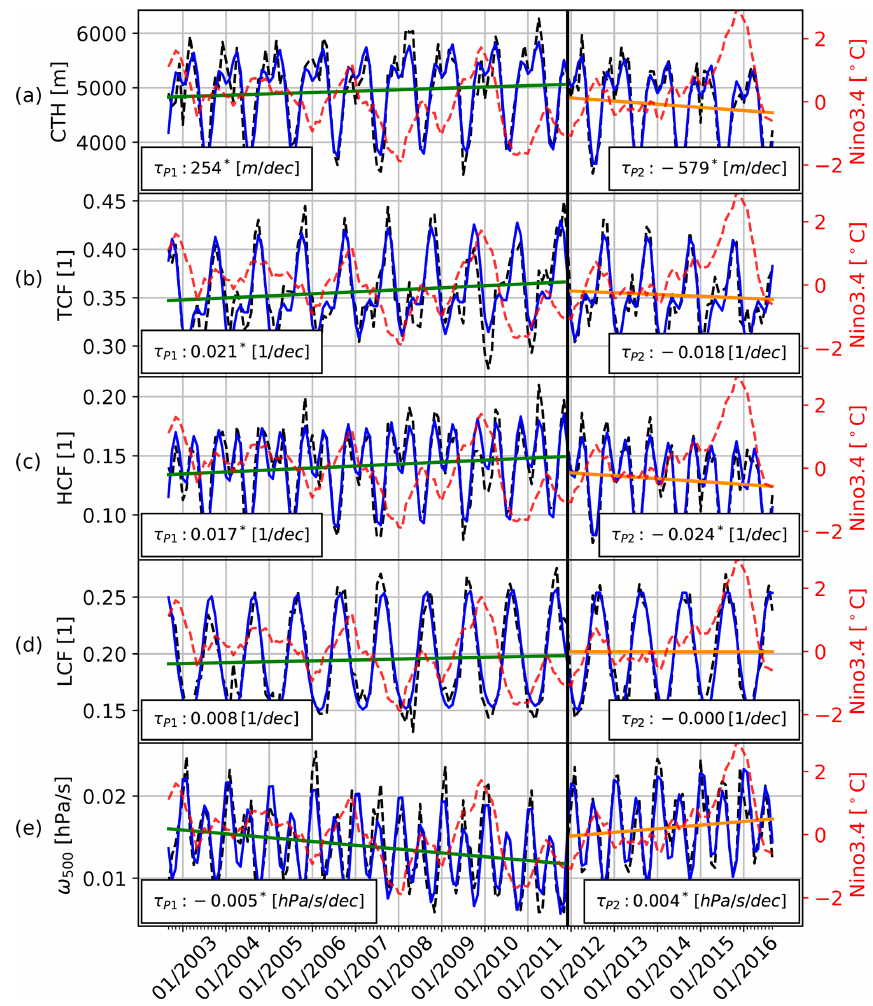
Figure 4. Quantification of temporal linear changes in the tropical Atlantic mean associated with ENSO phase transition. (a) CTH, (b) TCF, (c) HCF, (d) LCF, and (e) ω 500 . The MODIS data are displayed in black, and in blue the applied MLRM are shown. In red the Nino3.4 index is